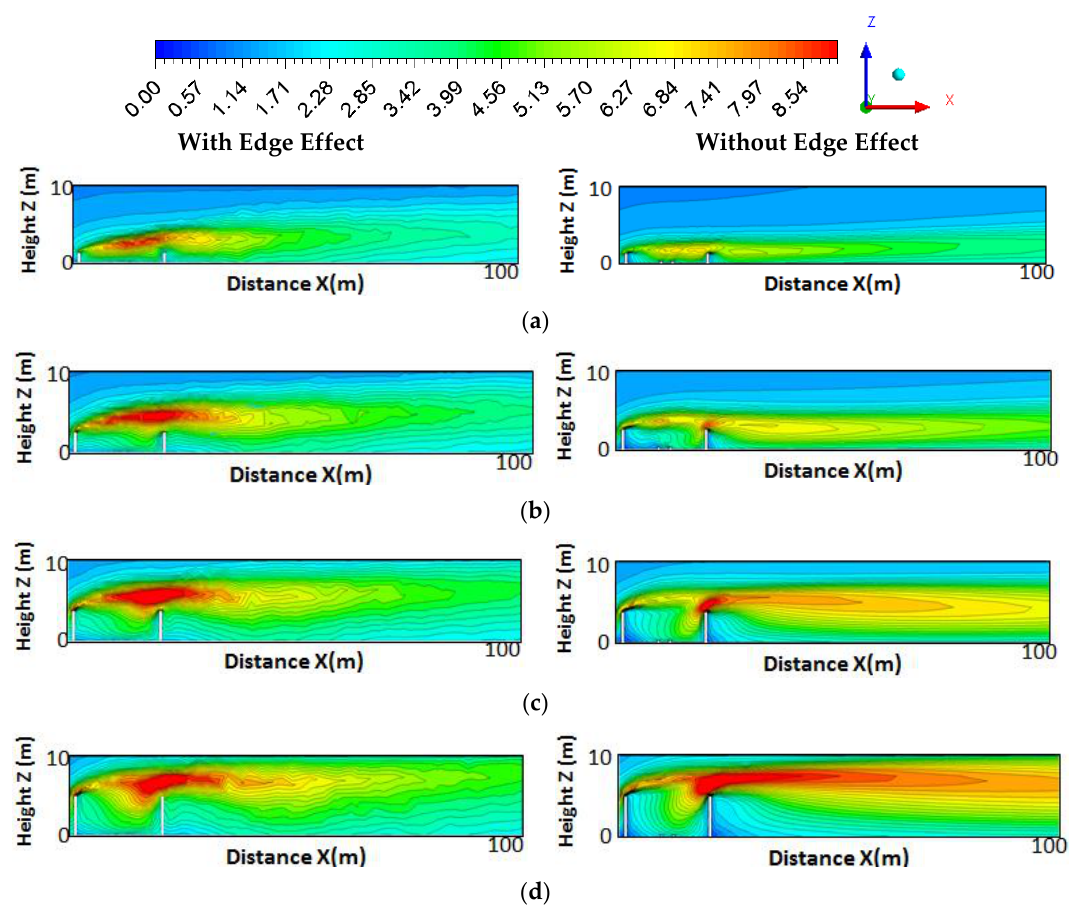
Figure 8. Contour of turbulence intensity in symmetry plane (Y = 90) for comparing with and without side edges under neutral condition. The noise barrier height is ( a ) 1 m, ( b ) 2 m, ( c ) 3 m, and ( d ) 4 m.